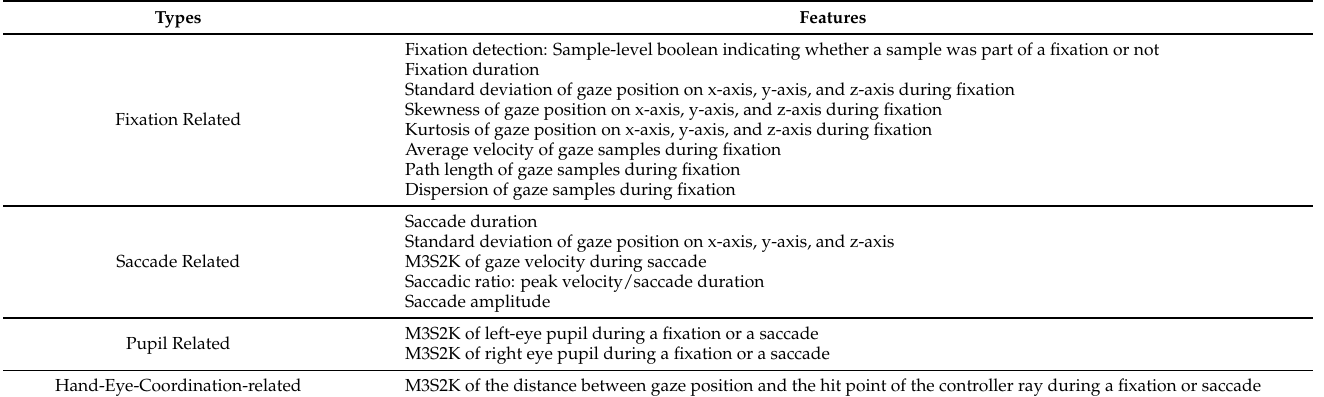
Table 2. Features derived from fixation, saccade, pupillary responses, and hand-eye